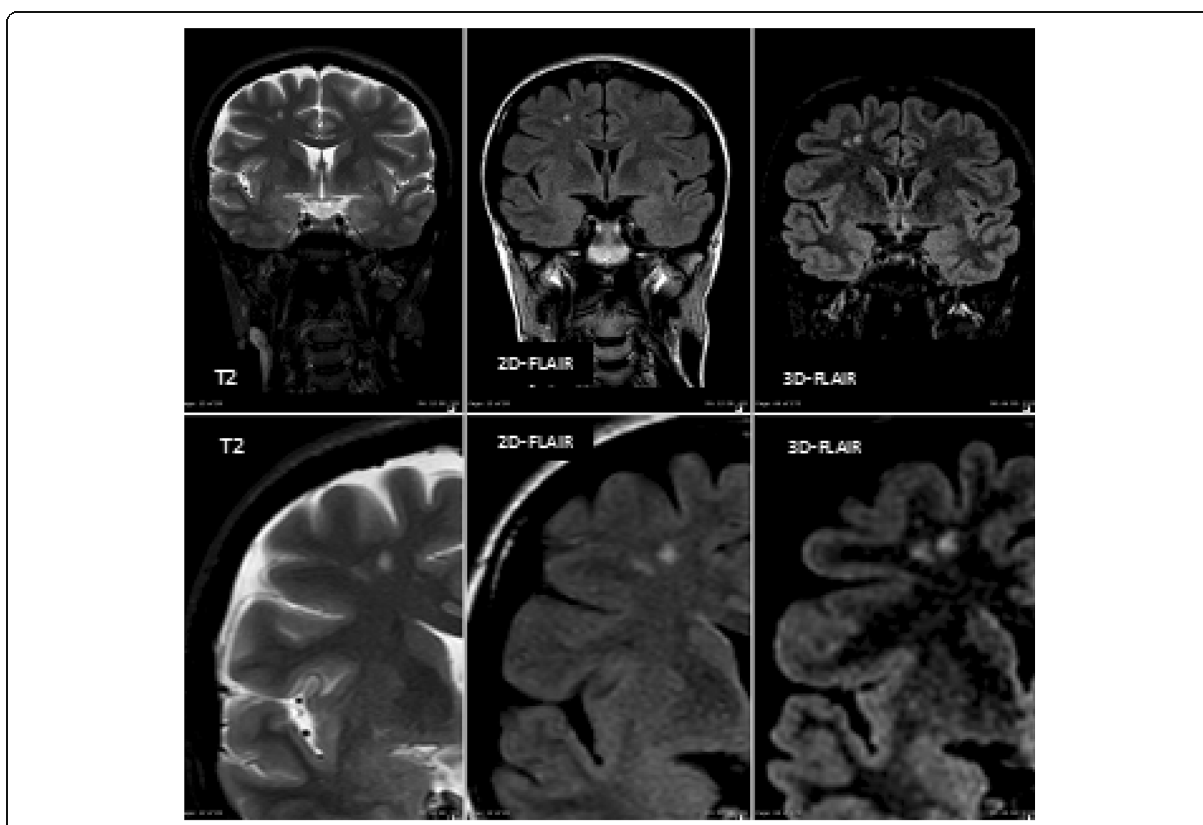
Fig. 4 Above row coronal T2, 2D FLAIR, and 3D-FLAIR image and below row is detail enlargement approximately corresponding to above images showing two hyperintense lesions in deep white matter more clearly distinguished on 3D-FLAIR than T2 and 2D-FLAIR